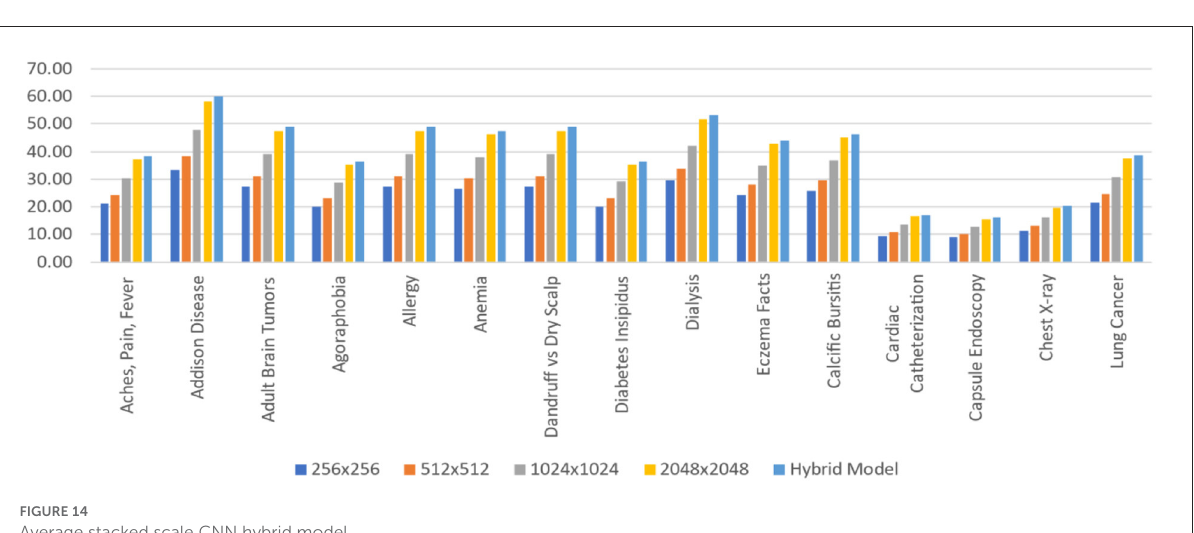
FIGURE14 Average stacked scale CNN hybrid